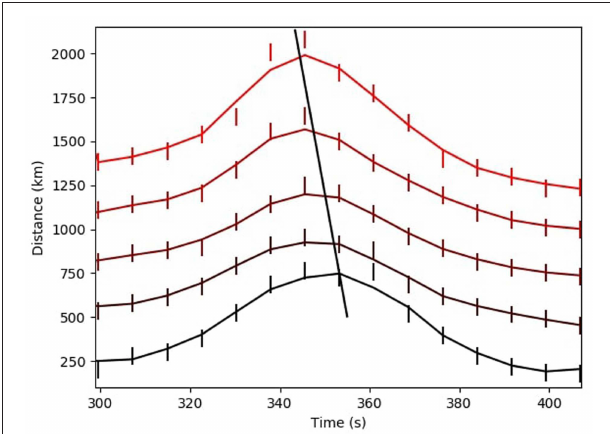
FIGURE 7 | Five parallel slits, spaced by five pixels, are placed perpendicular to each fibril. The widths, calculated from the fitted Gaussian along each slit, are plotted and displaced in the y-direction by five pixels = 250 km, the distance between each slit. The peaks and troughs of the width oscillations are fitted by a straight line, the gradient of which is approximately the phase